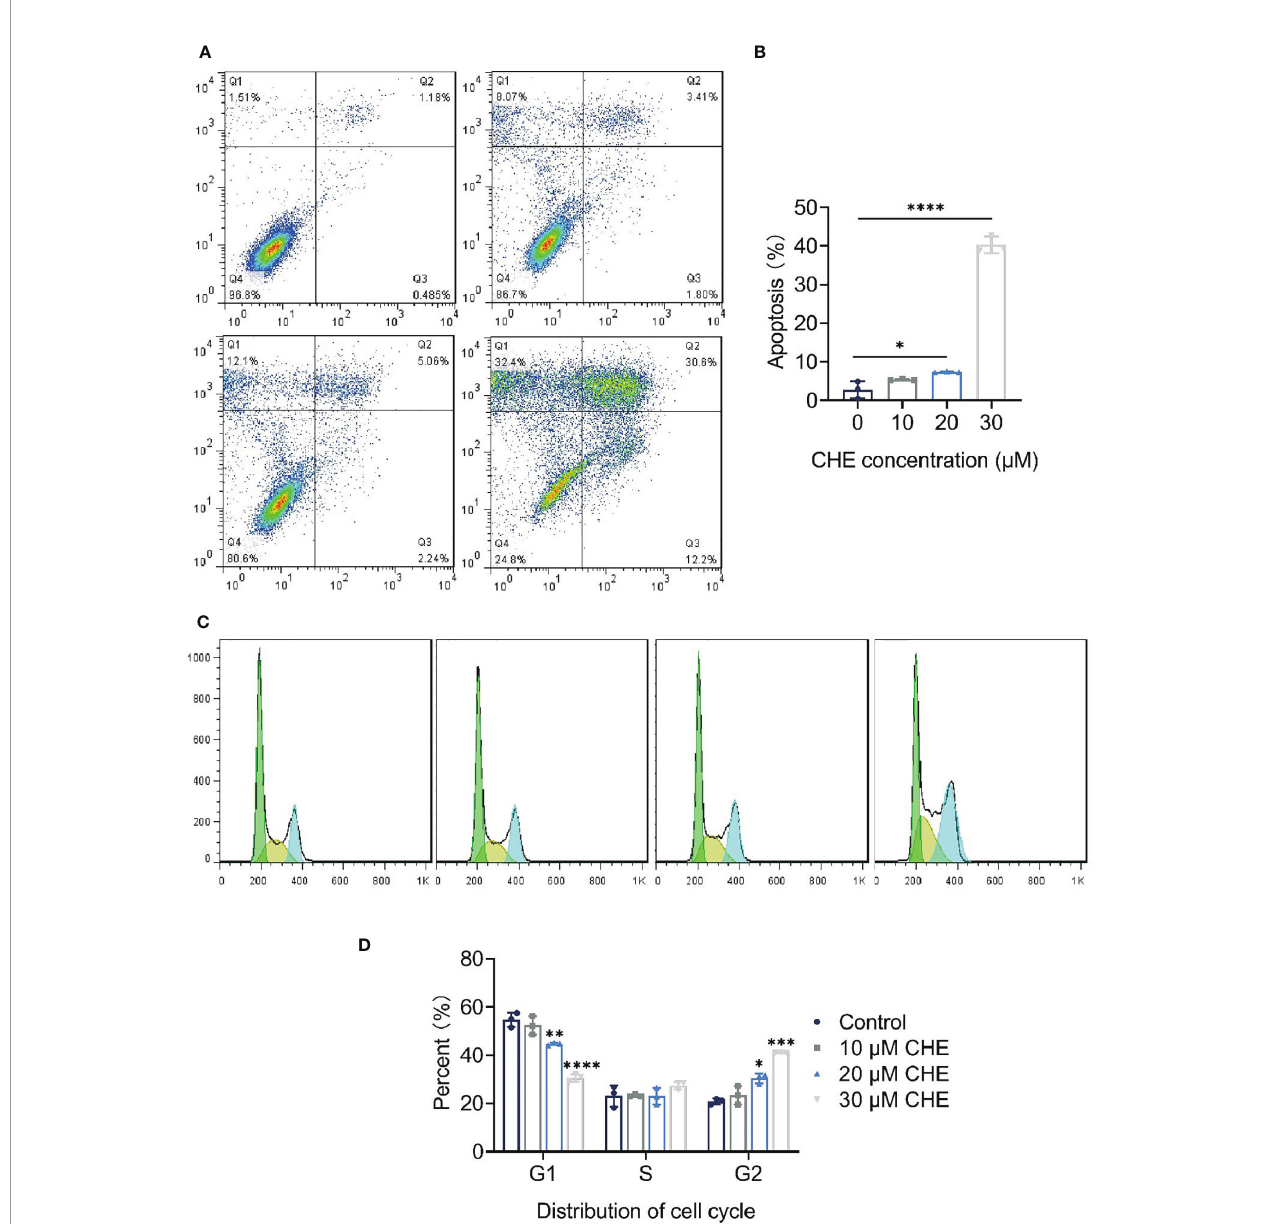
FIGURE 2 | CHE inhibited growth of HCC827 cells and induced apoptosis. (A, B) CHE induced the apoptosis of HCC827 cells. (C, D) CHE arrested HCC827 in G2/M phase. (****p < 0.0001, ***p < 0.001, **p < 0.01, *p <